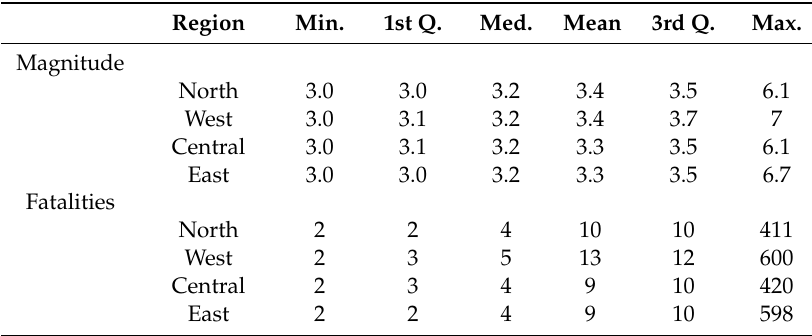
Table 5. Summary statistics of the magnitudes and number of fatalities in each region. The columns are the minimum (Min.), the first quantile (1st Q.), the median (Med.), Mean, third quantile (3rd Q.) and the maximum (Max.).